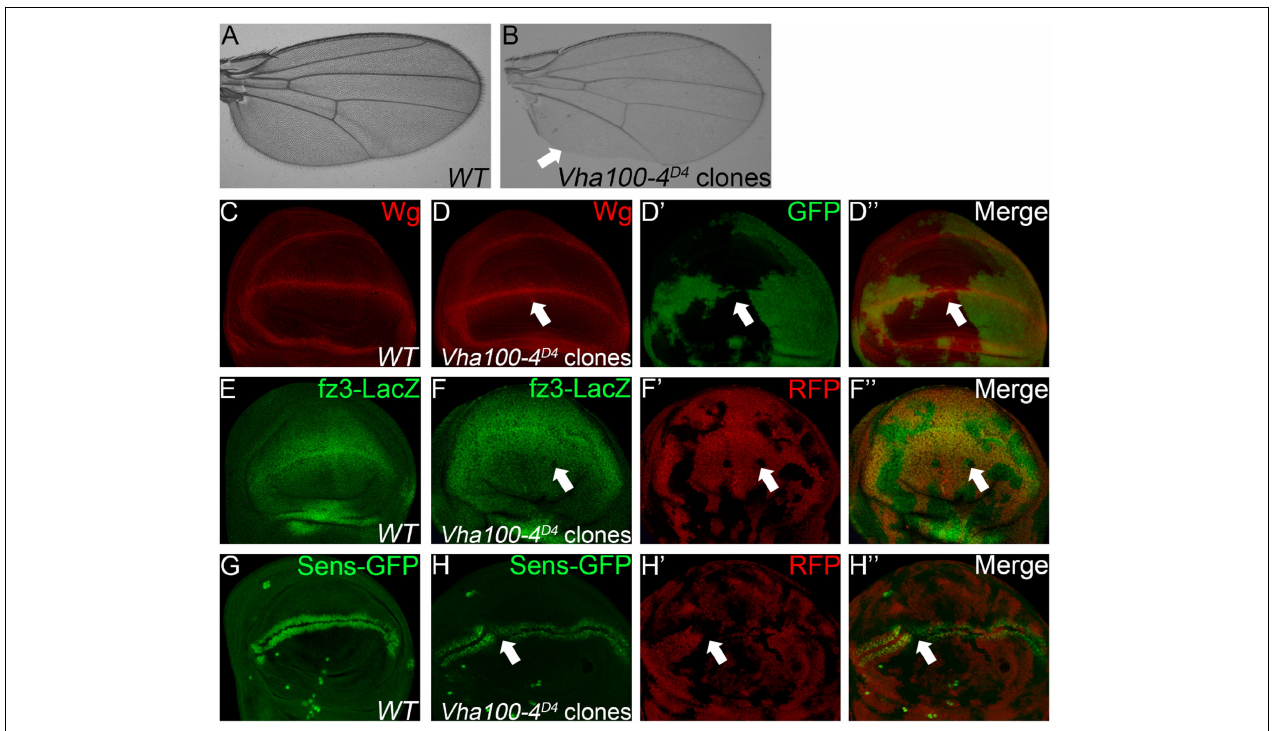
FIGURE 4 | Vha100-4 is required for proper activation of the Wg signaling pathway. (A,B) The adult wing of W 1118 stock is used as wild type control (A) . Wing margin notches and marginal bristle loss are observed in homozygous Vha100-4 D4 mutant clones (B) . (C,D) Immunostaining shows that Wg (red) is expressed by cells at the D/V boundary in the pouch of wild type wing disk (C) . Wg proteins (red) are accumulated in a subset of mutant Vha100-4 D4 clones ( n = 7/13; D ). (E,F) The Wg signaling reporter fz3-LacZ (green) is expressed by all cells in the pouch area of wing disk (E) . Expression of fz3-LacZ (green) is dampened in Vha100-4 D4 mutant clones ( n = 6/11; F ). (G,H) Sens-GFP (green) is expressed in two rows of cells which are above and below the D/V boundary (G) . Expression of the Sens-GFP reporter (green) was inhibited in a subset of Vha100-4 D4 mutant clones ( n = 7/12; H ). The mutant clones are marked by absence of GFP (D) or RFP (F,H) . Representative mutant clones are indicated by arrows. Scale bars: 0.5 mm in (A,B) and 10 µ m in (C–H)